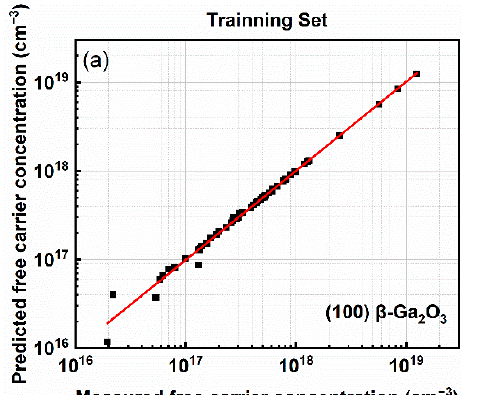
Figure 2. The parameter importance based on the trained fDNN model. The importance is ranked by the features containing the most information for the model to make a prediction of the free-carrier concentration in the films: ( a ) individual process parameters and ( b ) added with a created parameter: Si supplied per nm (mol/nm).